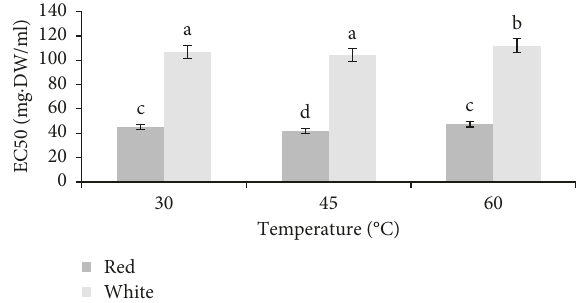
Figure 1: Comparison of ABTS radicals scavenging activity of red and white quinoa sprouts extracts.